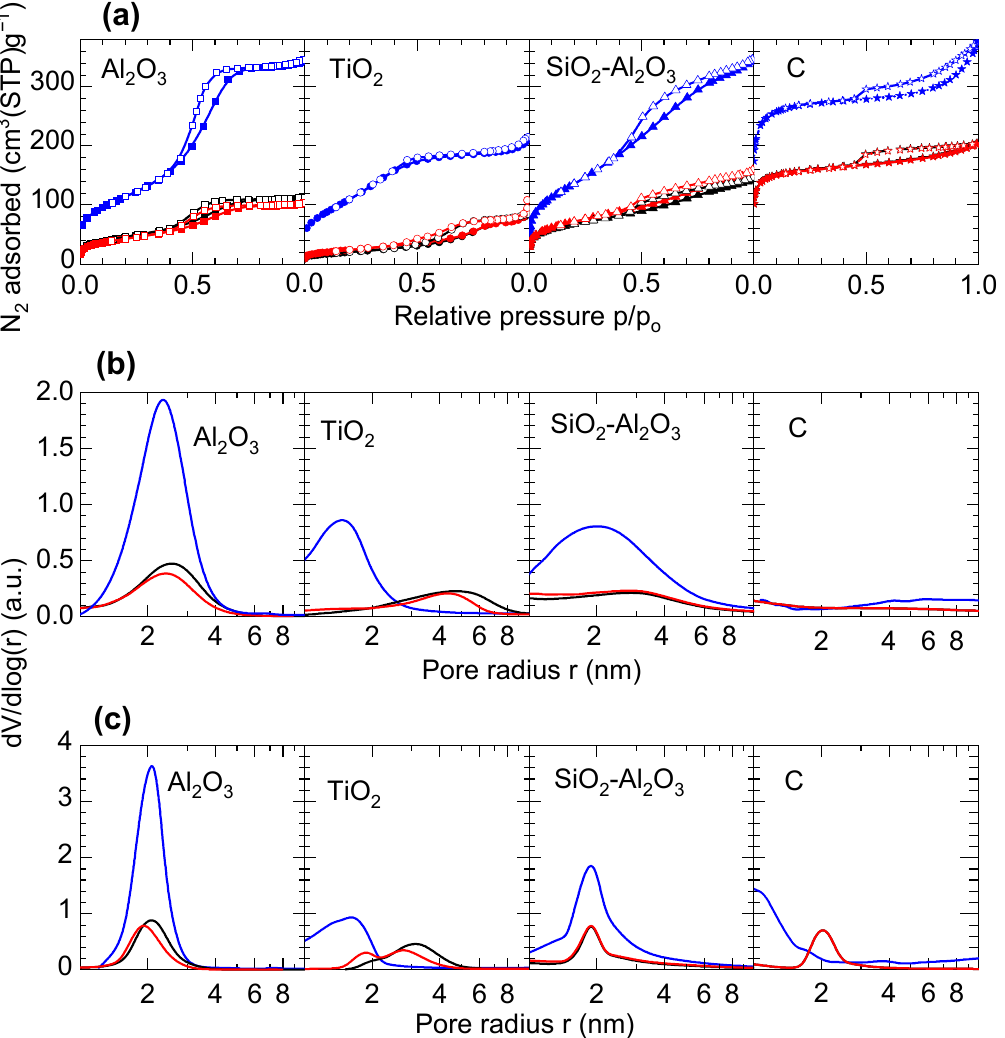
Figure 2. Textural properties of the support (blue lines), sulfided catalysts (black lines) and spent catalysts after 3 h time of stream at 50% conversion of octanoic acid (red lines). N 2 adsorption desorption isotherms ( a ), pore-size distribution from the adsorption branch of the isotherm ( b ), and pore-size distribution from the desorption branch of the isotherm ( c ).